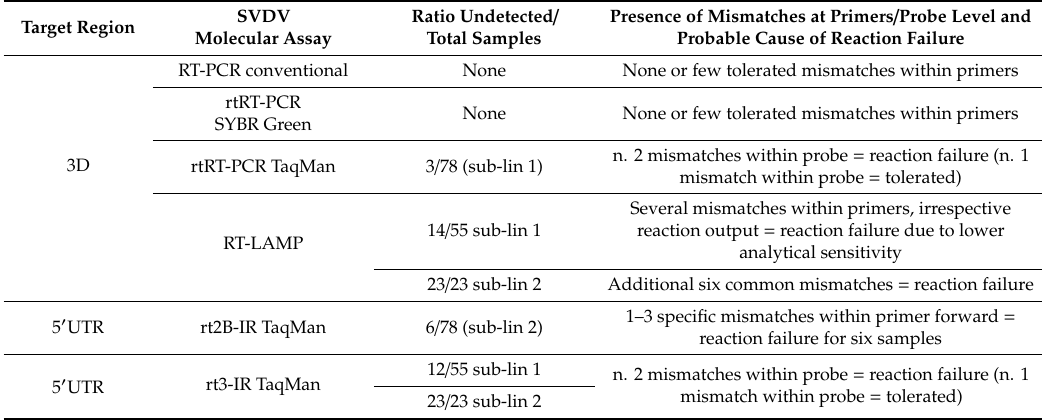
Table 4. Evidence of nt mismatches within primers / probe sequences, causing di ff erent levels of failure of the SVDV biomolecular